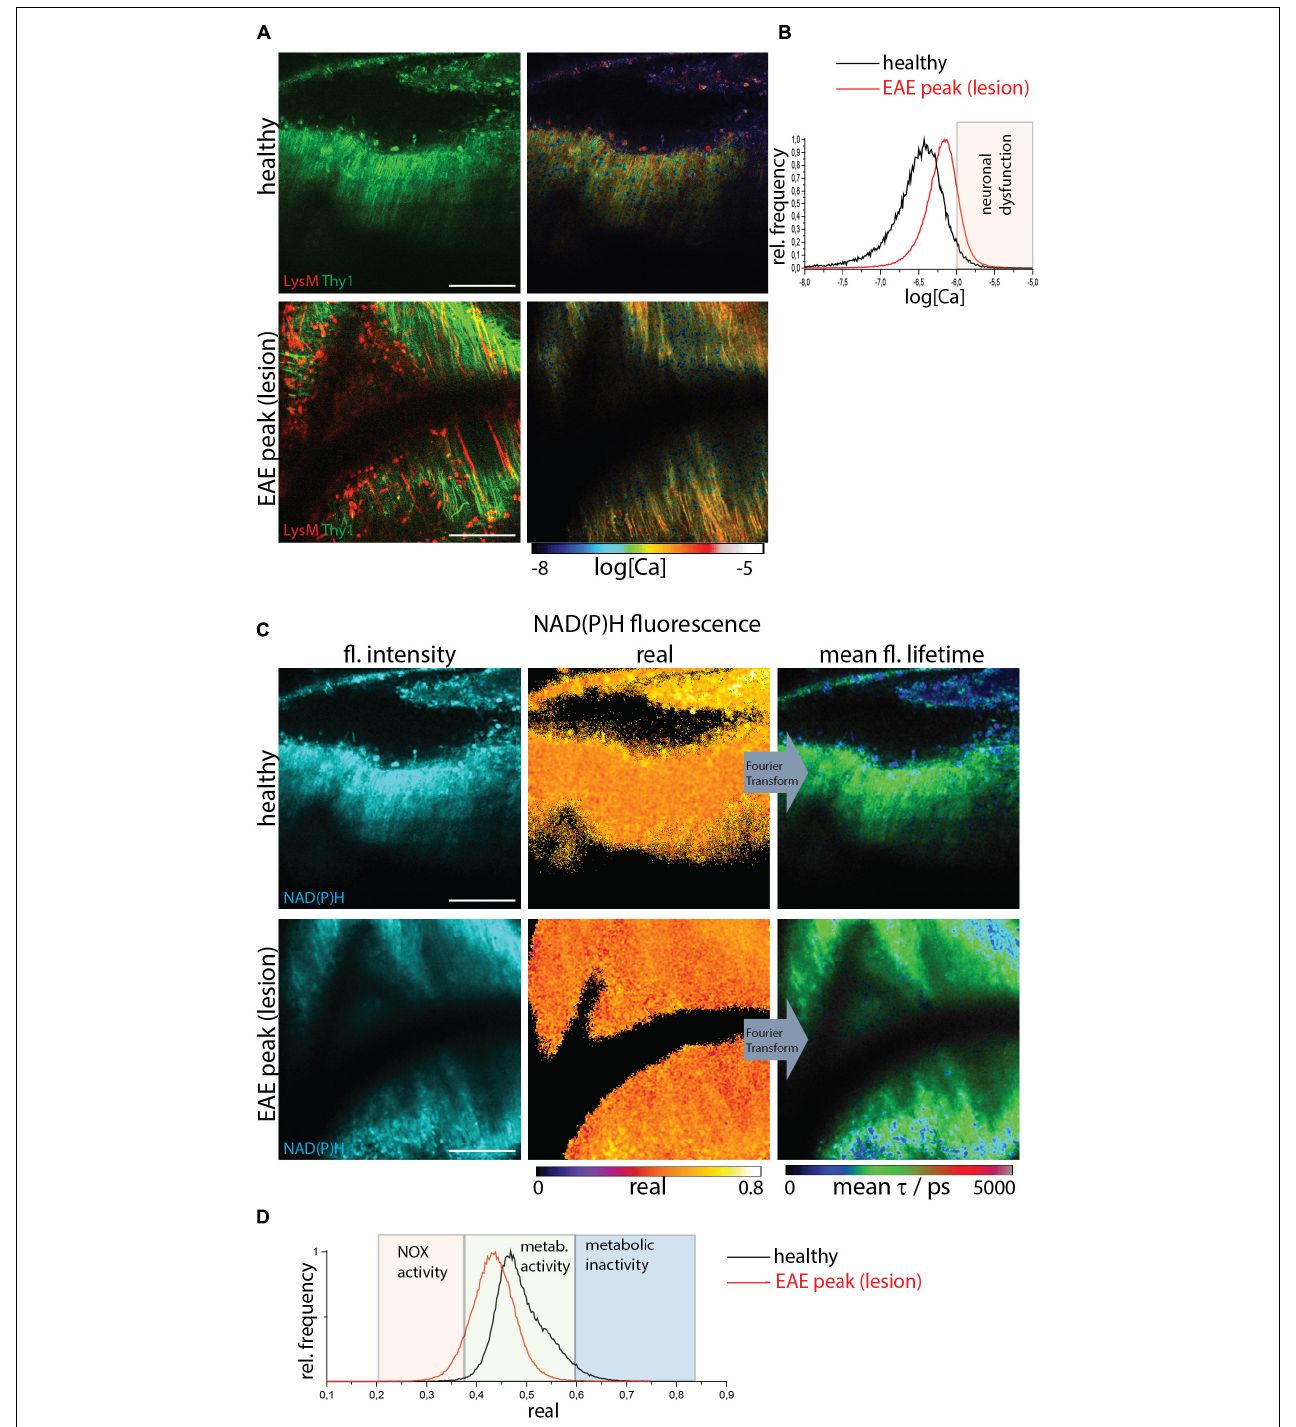
FIGURE 2 | NOX enzymes activation by NAD(P)H-FLIM and neuronal dysfunction by FRET-FLIM of TN L15 in the brain stem of healthy vs. EAE mice. (A) FRET-FLIM as a measure for neuronal dysfunction. Fluorescence intensity images of a healthy (upper image) and diseased (lower) brain stem of CerTN L15 x LysM tdRFP mice: tdRFP fluorescence in LysM + cells (red) and Cerulean and Citrine fluorescence in Thy 1 cells (green). Corresponding log[Ca] images of the regions shown by the fluorescence intensity images. (B) Histograms of neuronal Calcium in log[Ca] depicting the regime of neuronal dysfunction in the images in (A) . (C) NAD(P)H fluorescence intensity images, real part images and mean NAD(P)H fluorescence lifetime images of the same a healthy (upper image) and diseased (lower) brain stem of CerTN L15 x LysM tdRFP mouse as in (A) . (D) Histograms of the real part of the NAD(P)H phasor vector depicting the NOX enzymes activation regime in the images in (C) . (A–D) Are representative data for n = 2 healthy mice and n = 3 mice affected by EAE in peak of the disease. Scale bars represent 100 µ